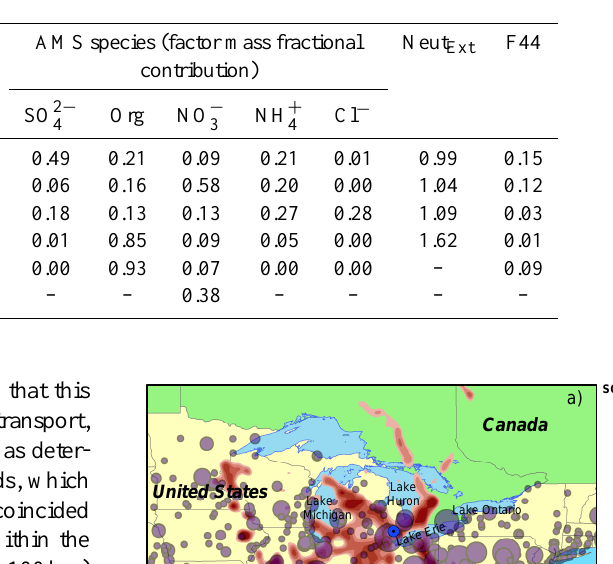
Table 2. Chemical composition of the six factors from the PMF Full MS analysis, extent of neutralization, and F44 for each factor’s organic fraction.